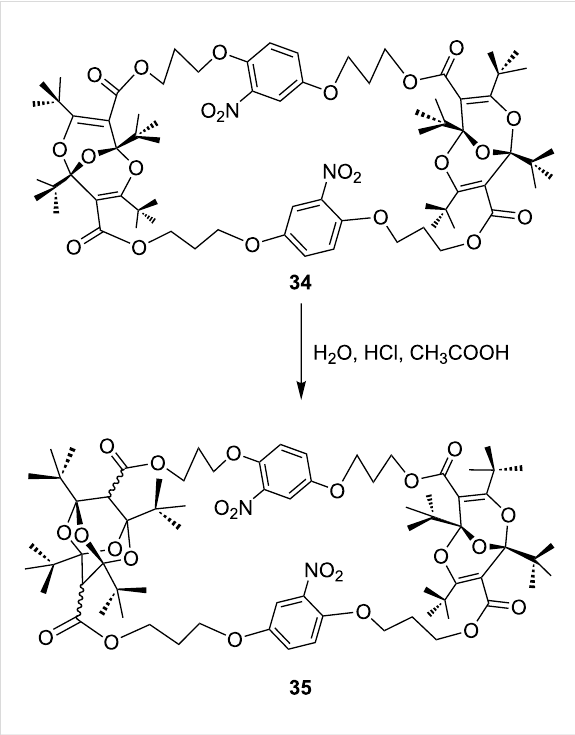
An even higher hindrance is induced by the p-tert- butylcalix[6]- arene moiety in 37 (Figure 3), which is obtained from the bisdioxine diacid dichloride 12 and calixarene [42]. The wider upper rim is clearly seen in the X-ray structure and the com- pound demonstrates a pronounced ability to extract Cs + ions from water into chloroform by forming endohedral complexes,